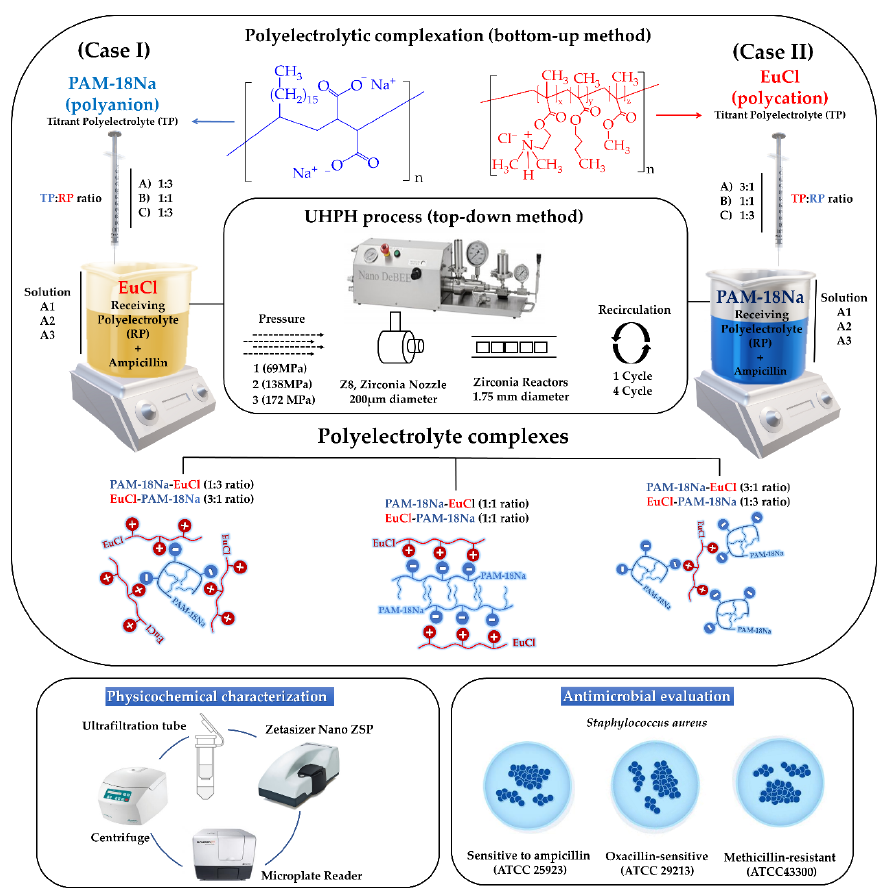
Figure 1. Scheme of the elaboration process, physicochemical characterization, and antimicrobial evaluation of ampicillin-loaded polyelectrolyte complex.